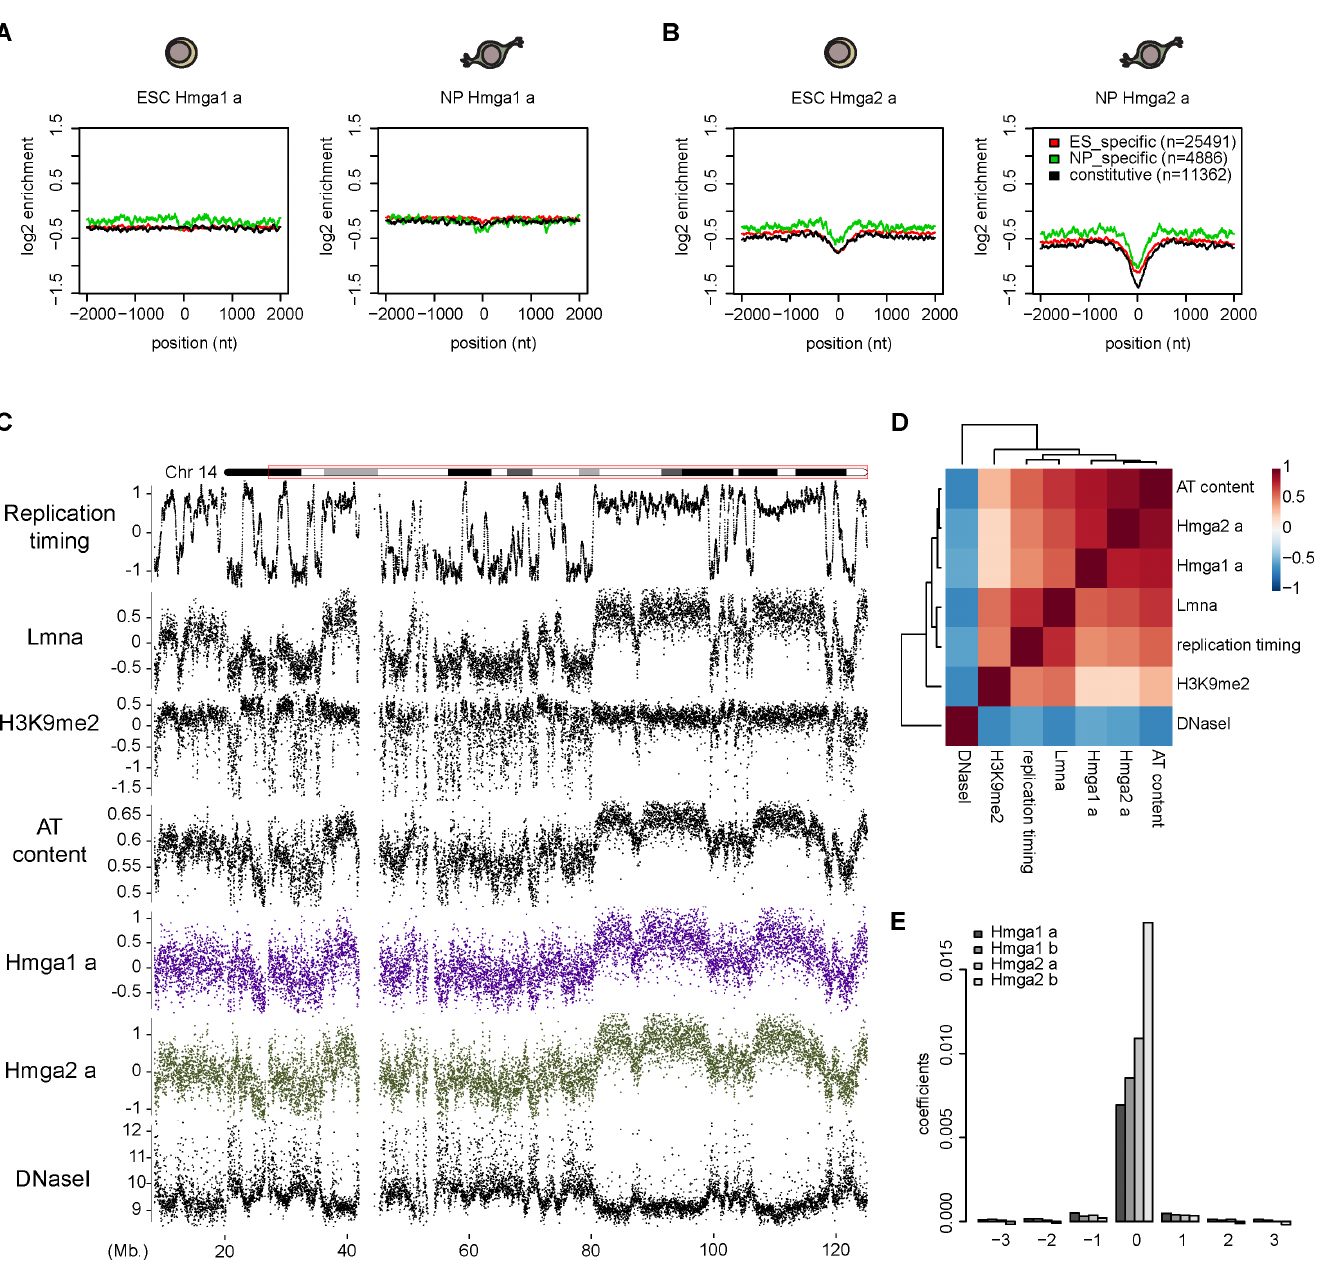
Fig 4. Genomic distribution of Hmga-enriched regions and AT-rich DNA. (A) Average profiles of log2 enrichment values over DBD-mutant at LMR regulatoryregions.Shown are ESC and NP signal for replicate “a” of Hmga1. Average signal (smoothedover 51 nts) is shown over a 4 kb window centered at ESC-, NP-specific and constitutive LMR midpoints, shown in red, green and black respectively. This revealslack of Hmga1 enrichment at both constitutive and cell-type specific regulatory regions. (B) Same as in (A) for replicate“a” of Hmga2. A depletionrather than an enrichmentis observedat the indicatedregulatoryregions. (C) Chromosome-wide profiles of the indicatedgenomicand epigenomic features in ESC. Each datapointrepresentsthe signal over a 10kb tiling window(replicationtiming = mean late/earlyS-phase ratios, Lmna = DamID LaminA, Hmga = input-normalized enrichment over DBDmutant, H3K9me2= H3K9me2enrichment over input). (D) Genome-wide correlation heatmap of replicationtiming, LaminA, H3K9me2,DNaseI cut frequency, AT content and Hmga1-2as in Fig 1C (10kb tiling windows, colors indicate the Pearson correlationcoefficient). (E) Linear model of Hmga protein bindingat 1 kb windowsbasedon the AT content of the windowitself and the 3 neighboring ones, both upstream and downstream. Plotted are the values of the coefficientsfor each spatialposition groupedby sample. The AT content of the windowitself has by far the largest coefficientsand contributions from neighbouring windows lead to negligibleimprovements in predictivepower (cf S7E Fig).